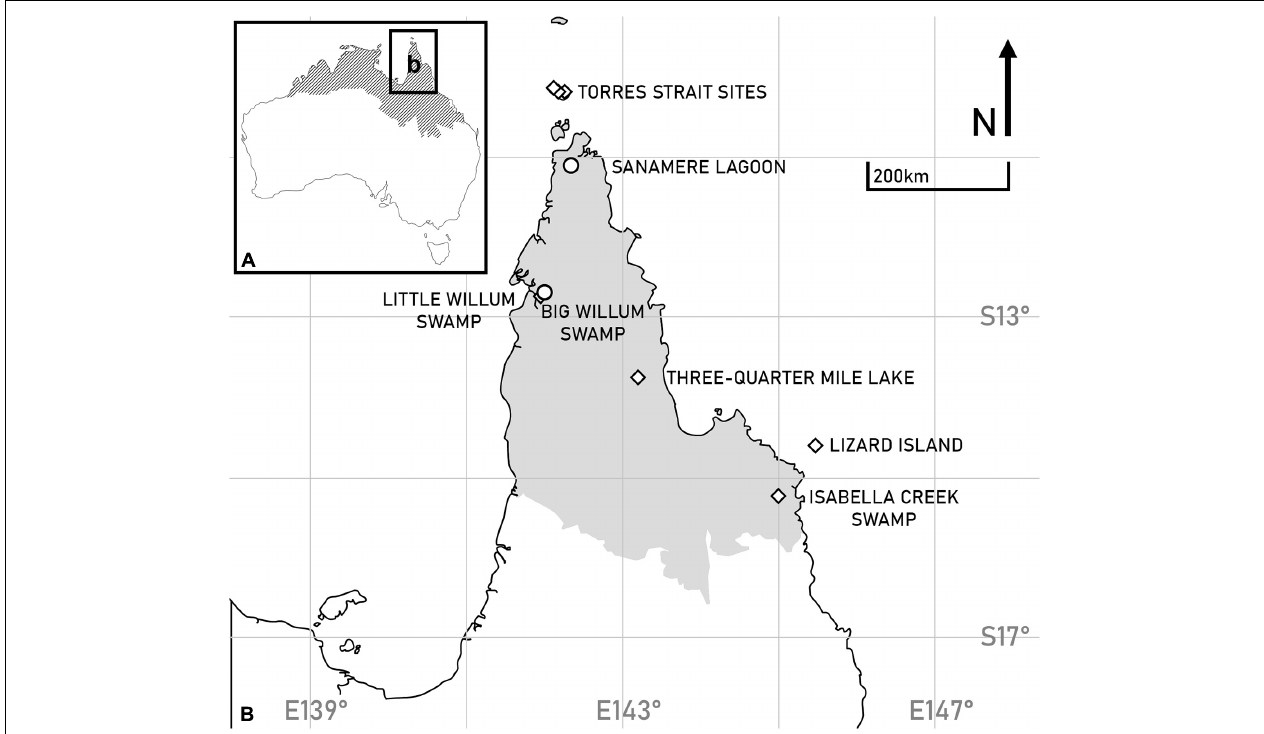
FIGURE 1 | Site locations for new records presented in this paper: (A) Australia with the extent of savanna vegetation indicated by shading (see Fox et al., 2001), showing the study area of Cape York Peninsula, (B) the study area with locations of new records marked with circles, existing record locations marked with diamonds, and the Cape York Peninsula bioregion is shaded in gray (after Department of Agriculture, Water and the Environment, 2021). For a detailed map of paleoenvironmental records across all of northern Australia see Reeves et al. (2013).